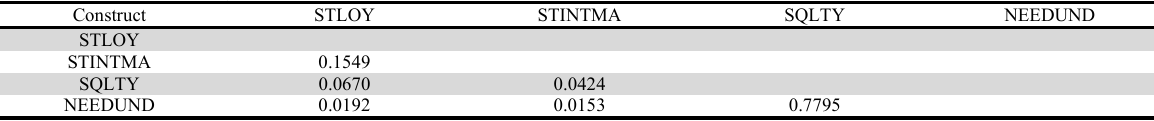
Discriminant Validity (HTMT